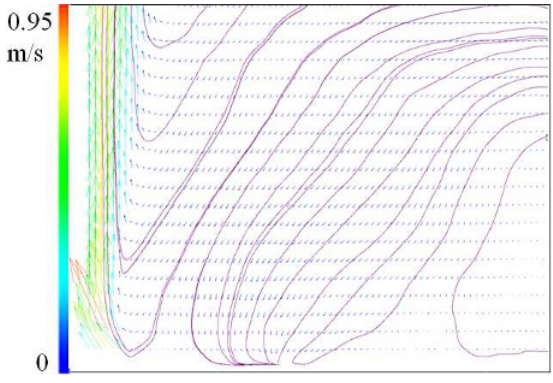
Fig. 7. The flow from the convector for the wall temperature 19.8 °C